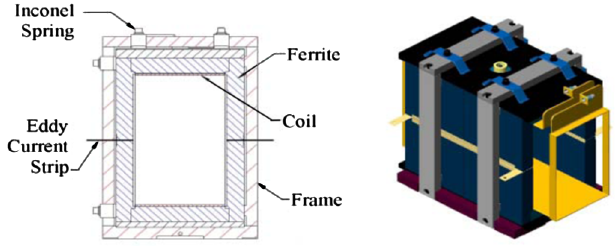
FIG. 1. Extraction kicker magnet cross section and